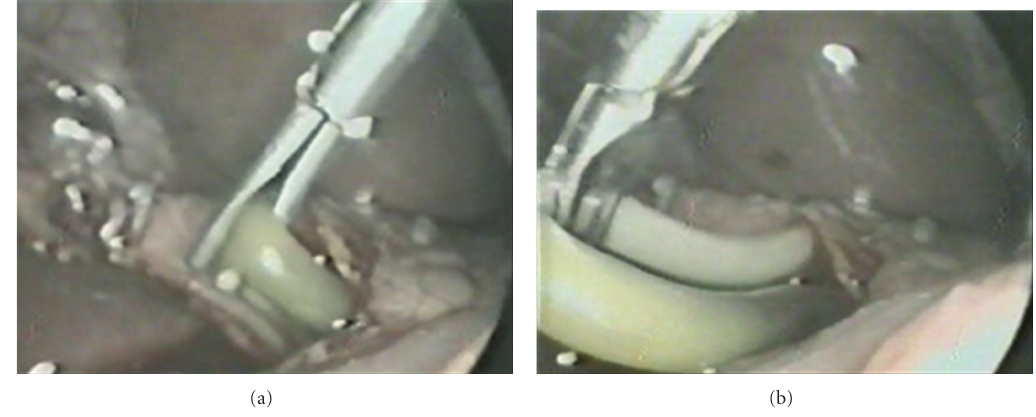
Figure 4: Intraoperative: extraction of common bile duct